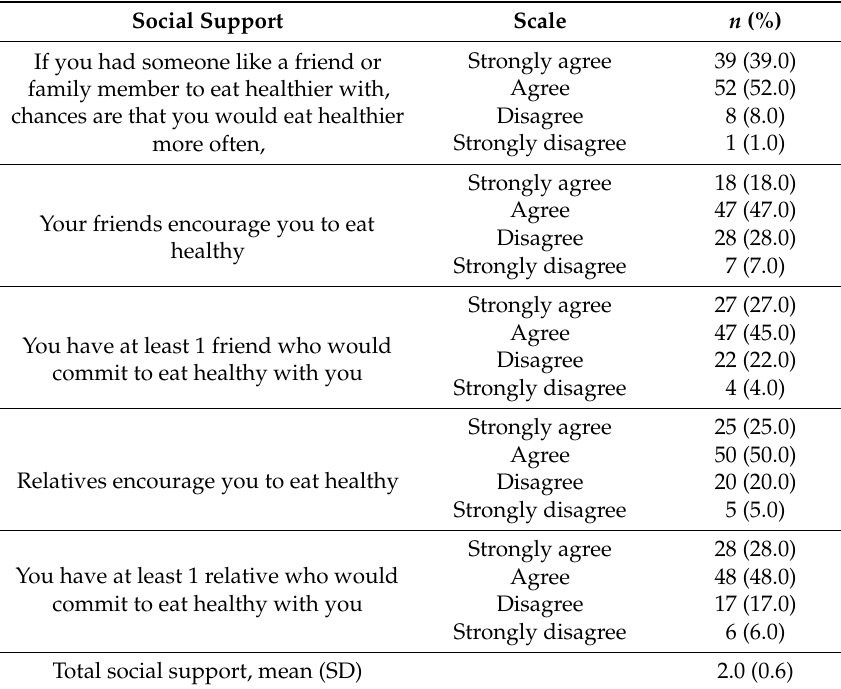
Table 5. Participants’ self-reported social support for healthy eating ( n = 100).